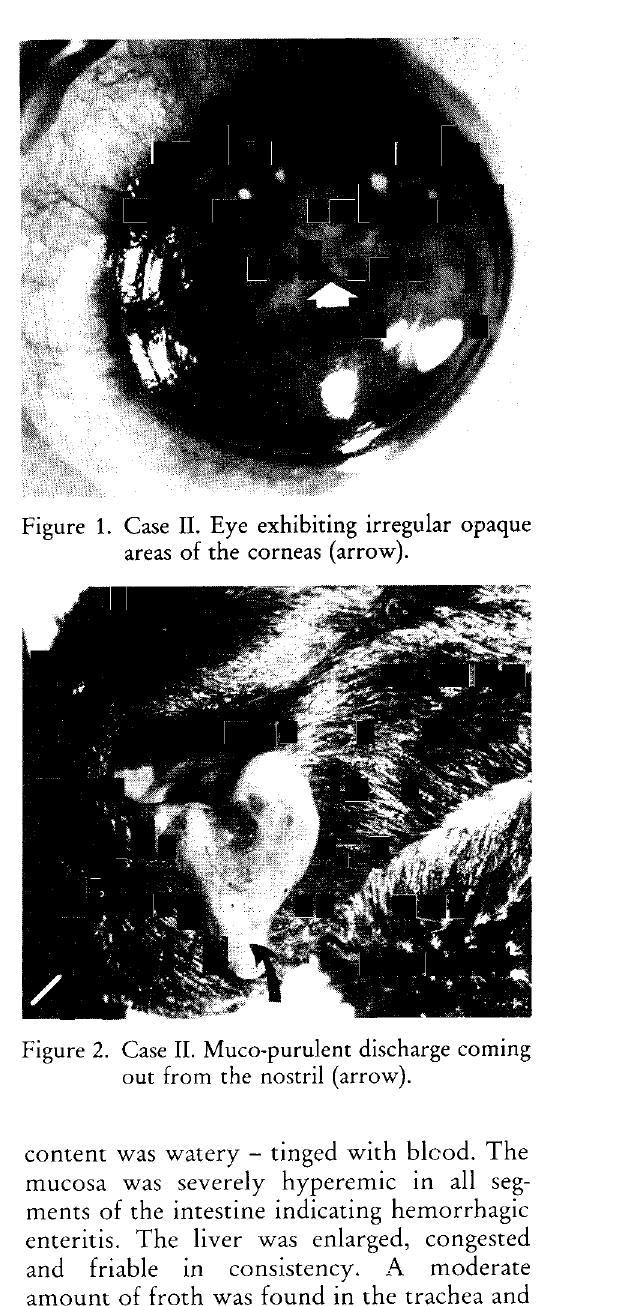
Figure 1. Case II. Eye exhibiting irregular opaque areas of the corneas (arrow).